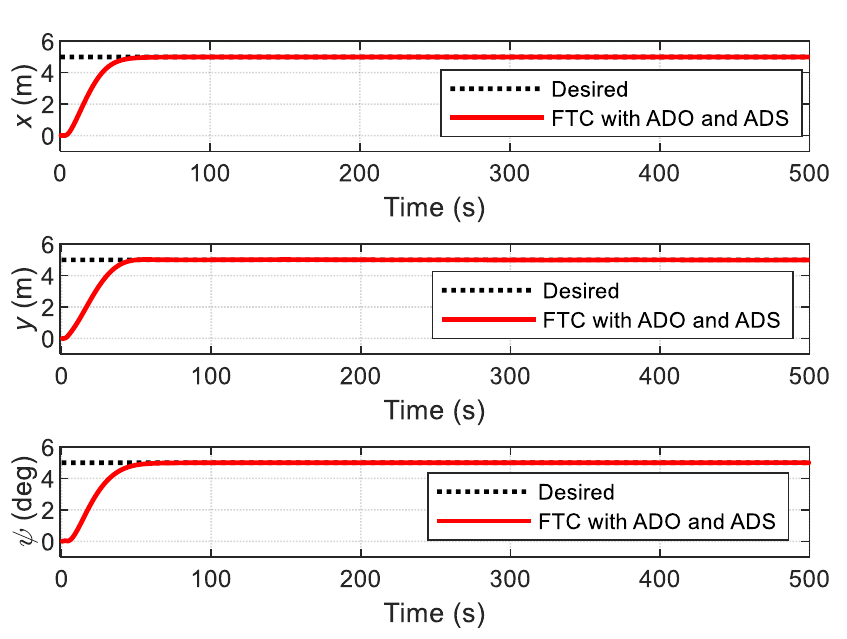
Figure 17. The forces of each thruster.